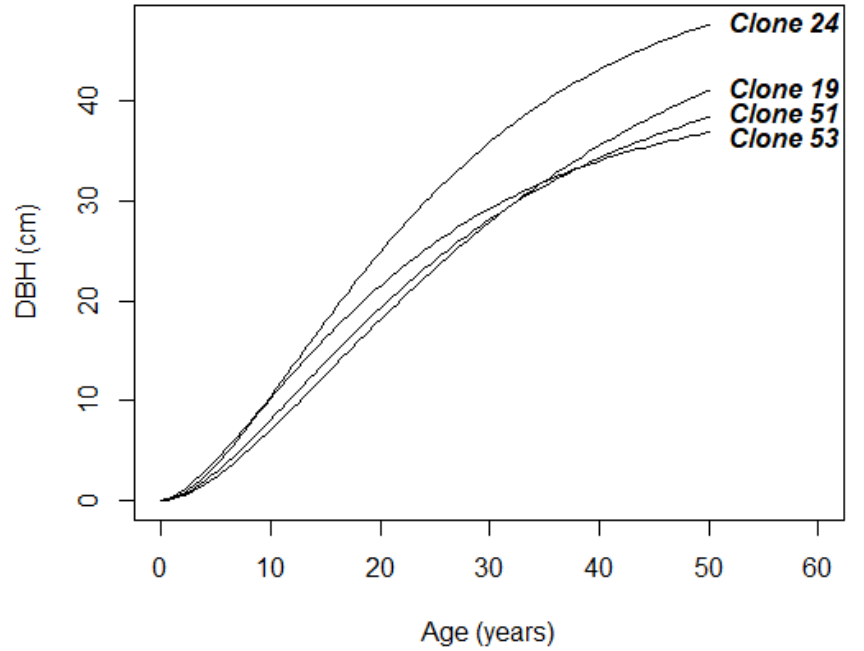
Figure 5. Growth curves of the selected clones (19, 24, 51, 53) with markedly different DBH growth trajectories.